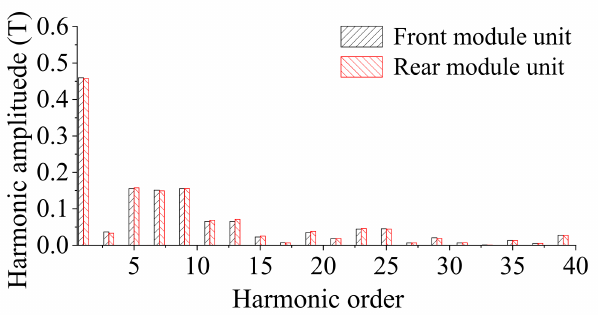
Figure 13. Armature reaction air-gap flux density harmonic distributions for AMA-FRPM